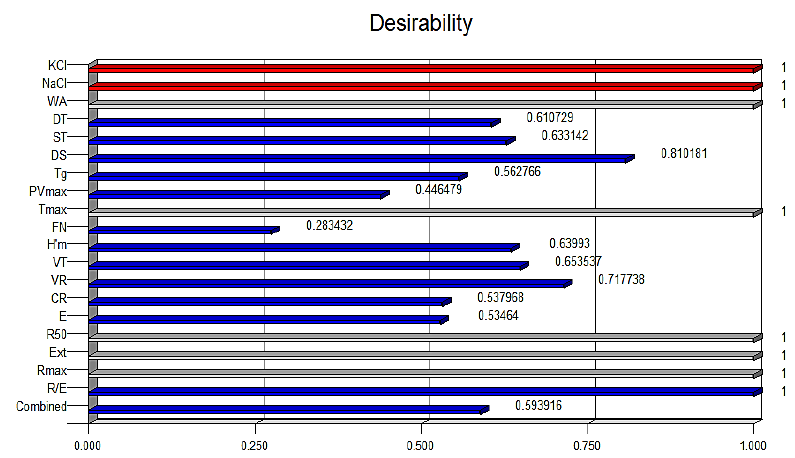
Figure 4. Desirability function scores for the independent variables and the studied dependent variables.